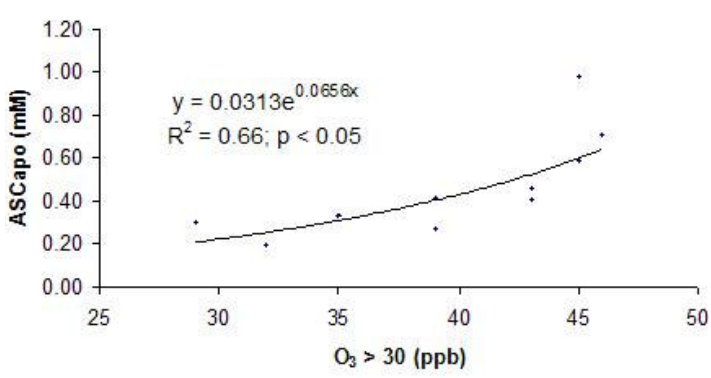
FIGURE 5. Regression for reduced apoplastic ascorbic acid (ASCapo) and ozone concentrations higher than 30 ppb (O 3 > 30 ppb). n =